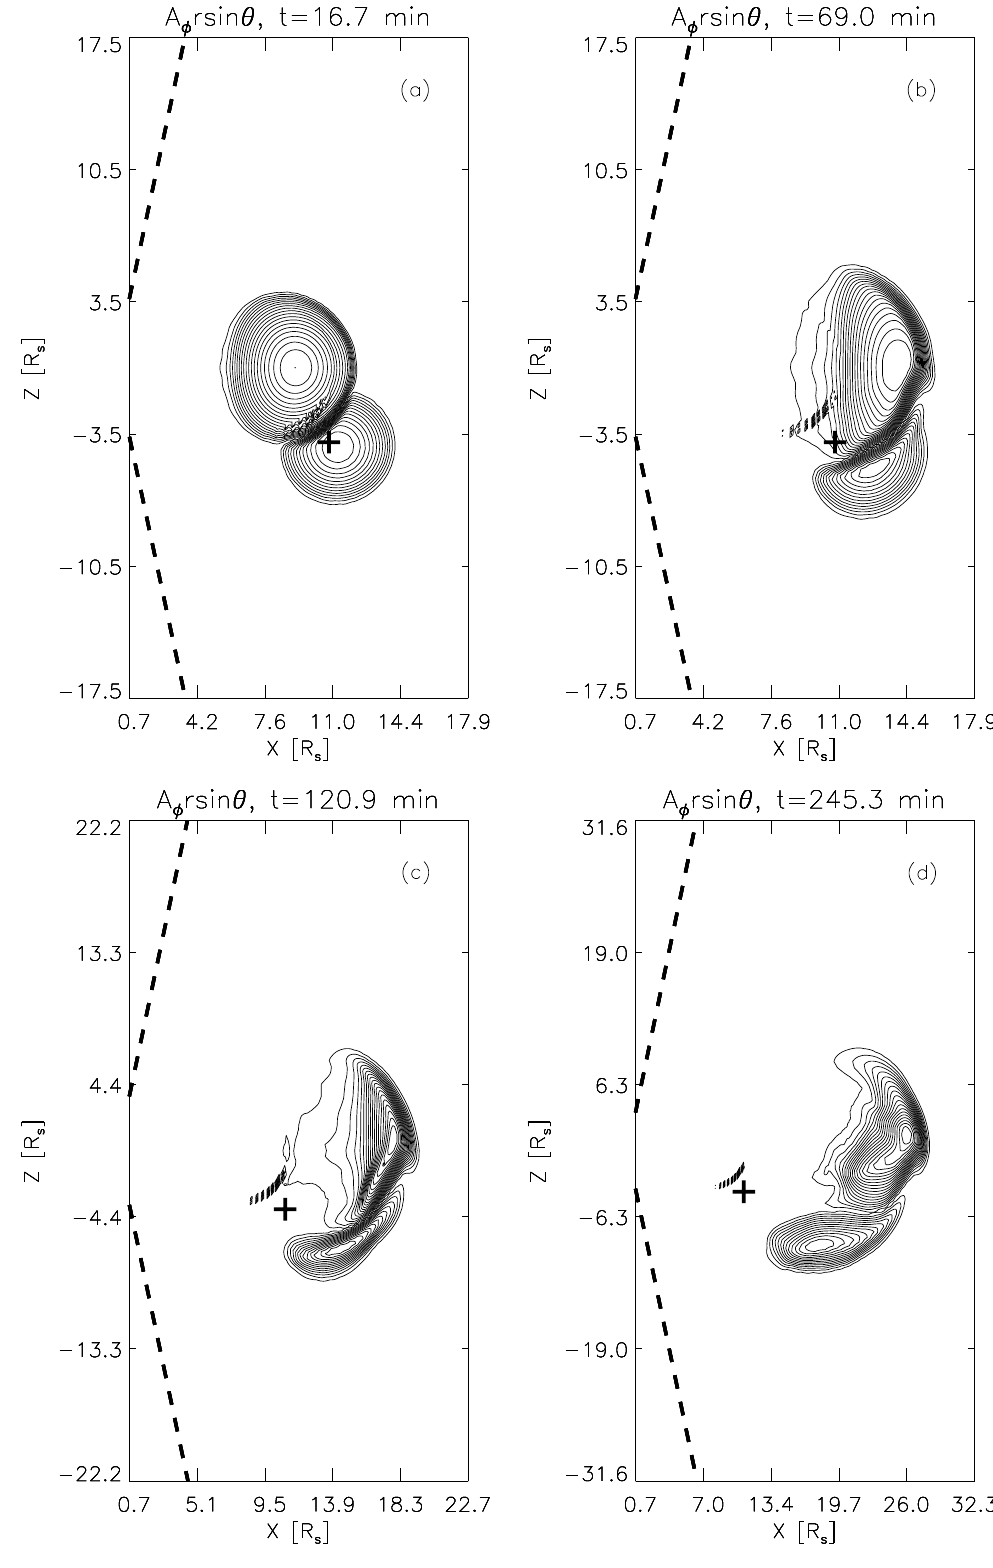
Fig. 5. As Fig. 4, except that the two CMEs now have opposite senses of field